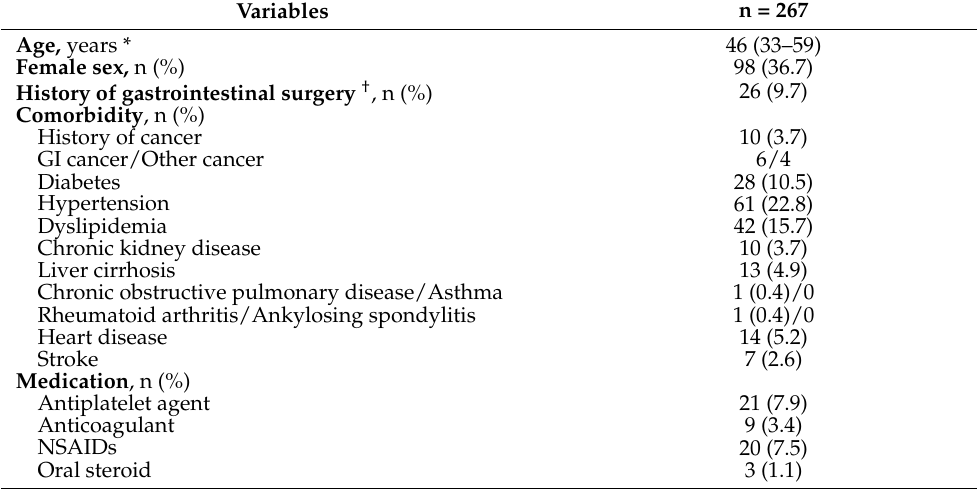
Table 1. Baseline characteristics of